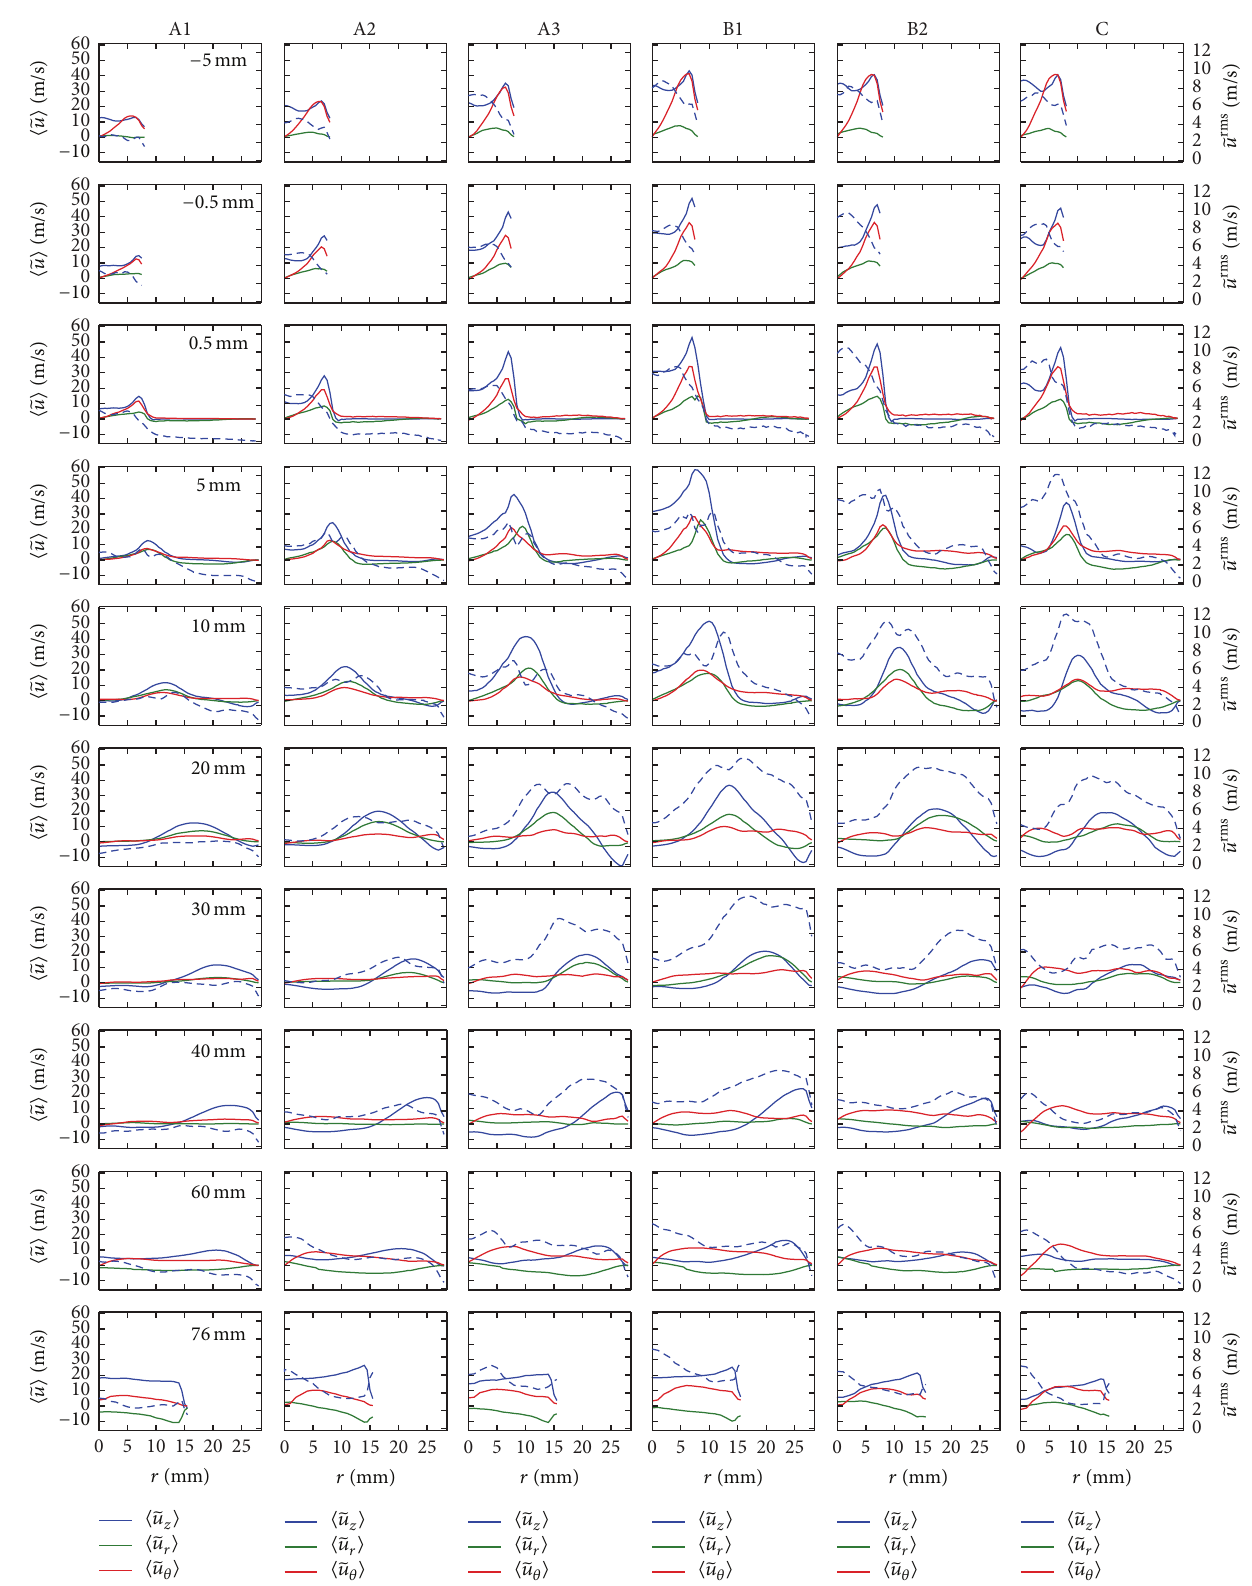
Figure 9: Profiles of mean velocity components for all cases at different axial positions: axial (blue solid lines), radial (green solid lines), tangential (red solid lines), and RMS (dashed